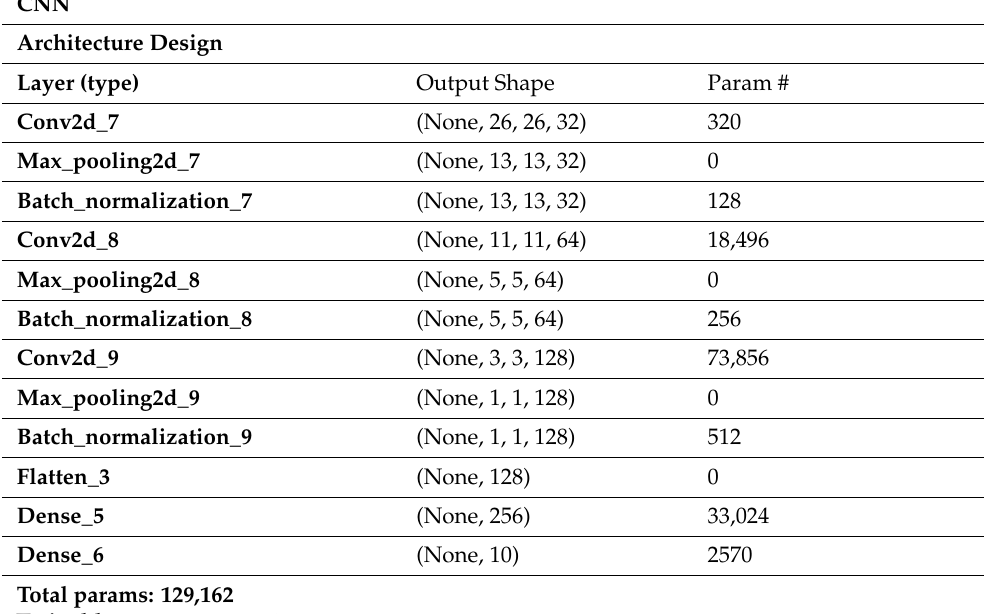
Table 4. The CNN architecture